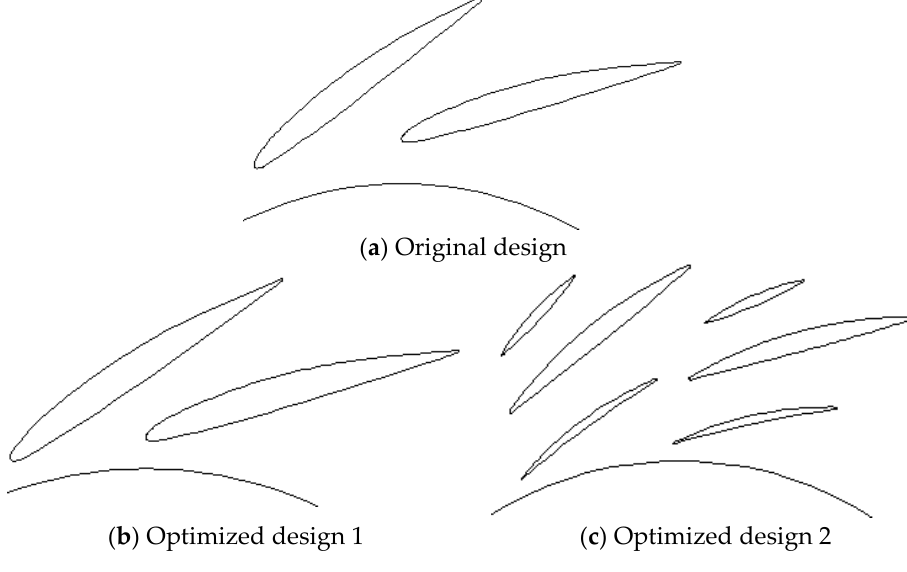
Figure 10. Geometric structure of the vaned diffuser.